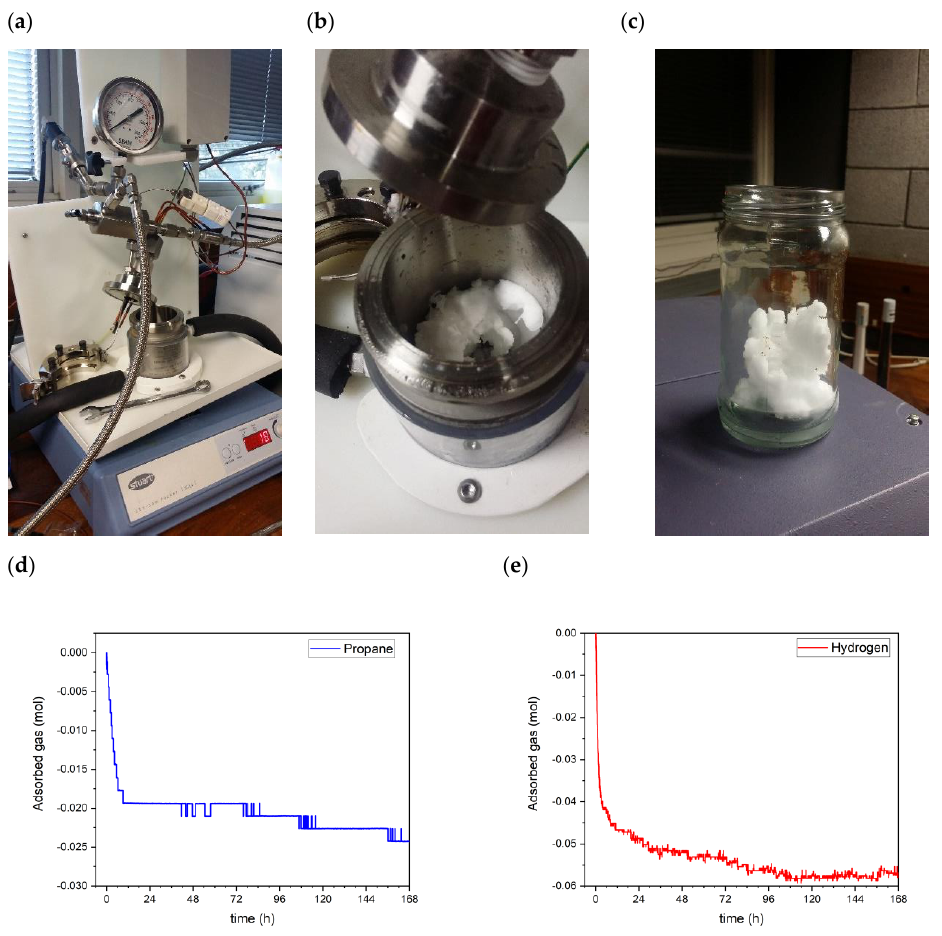
Figure 6. ( a ) High-pressure apparatus used for hydrogen growth and hydrogen storage study, ( b , c ) the formed hydrate immediate after pressure release and opening the reactor, ( d ) Number of propane moles adsorbed during the formation of the hydrate in the first 7 days under 4 bar pressure of propane, ( e ) Number of hydrogen moles adsorbed during the storage step in the second 7 days under 25 bar pressure of hydrogen at 1.5 °C.